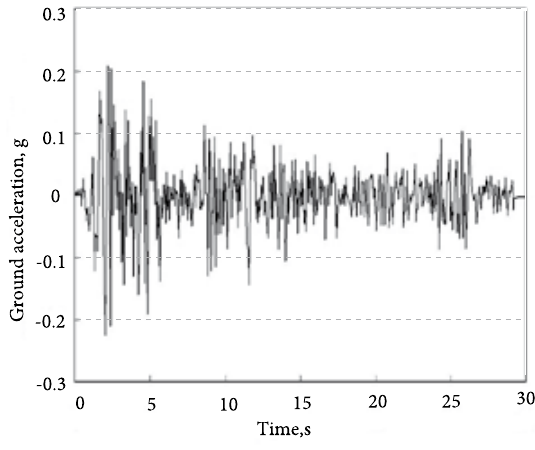
Fig. 6. El Centro earthquake (NS, 1940, EPA = 0.224 g)